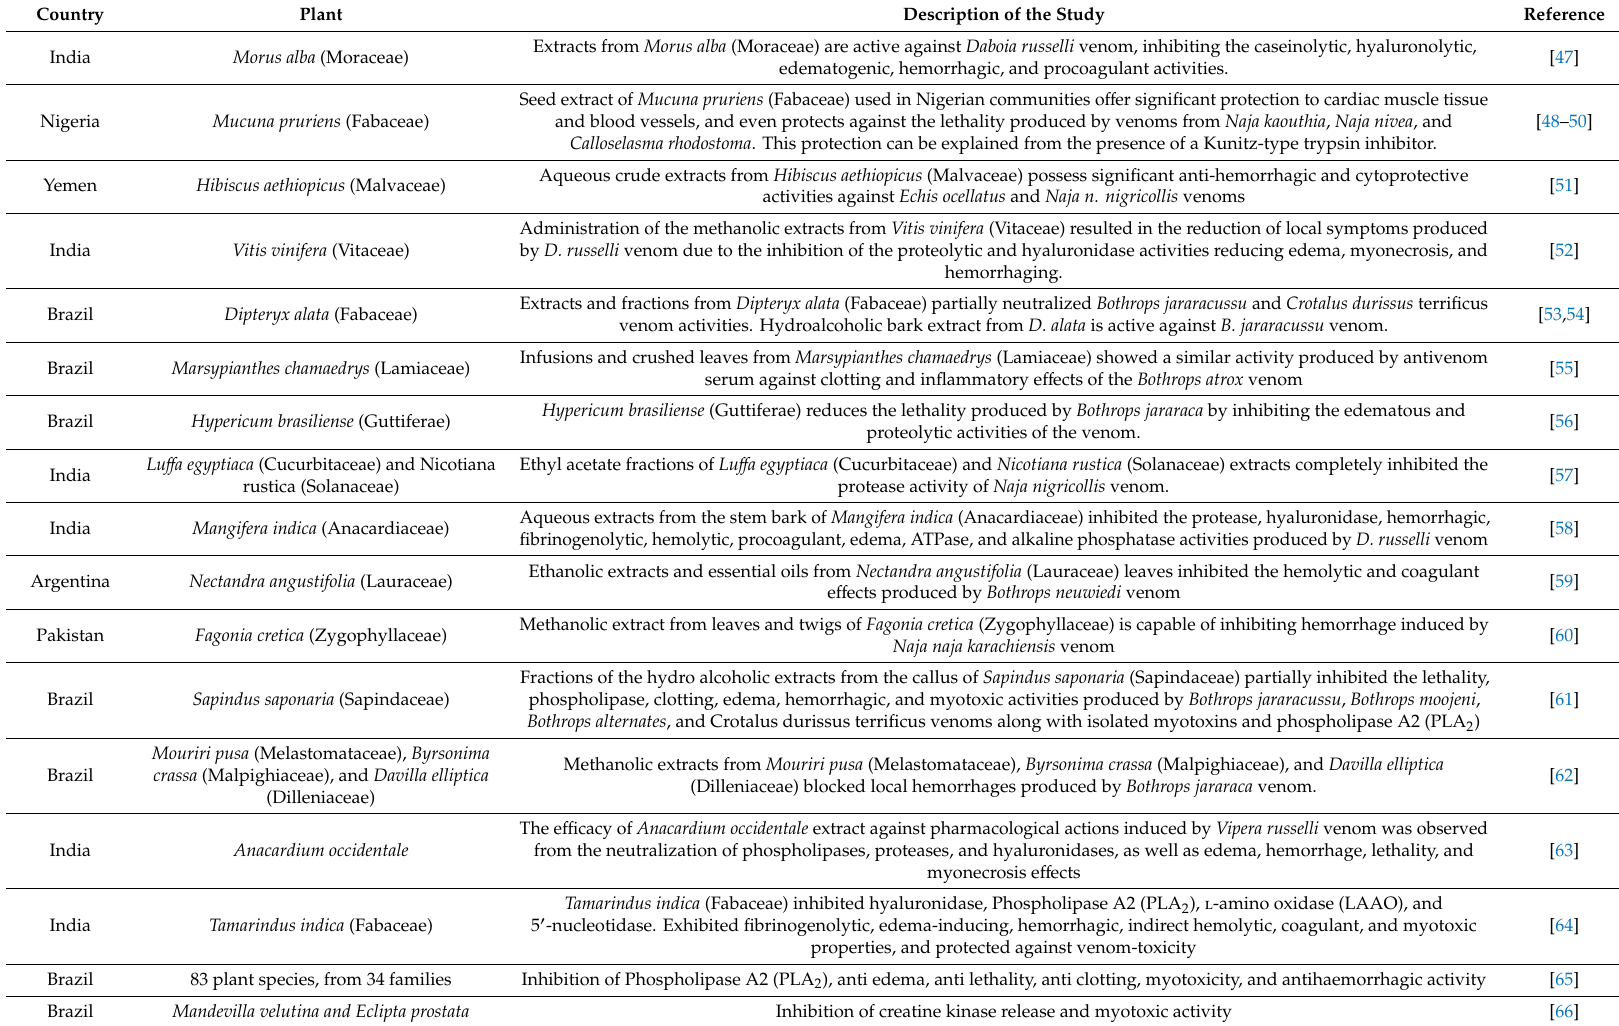
Table 1. Research and ethnopharmacological studies from di ff erent countries for the treatment of snake